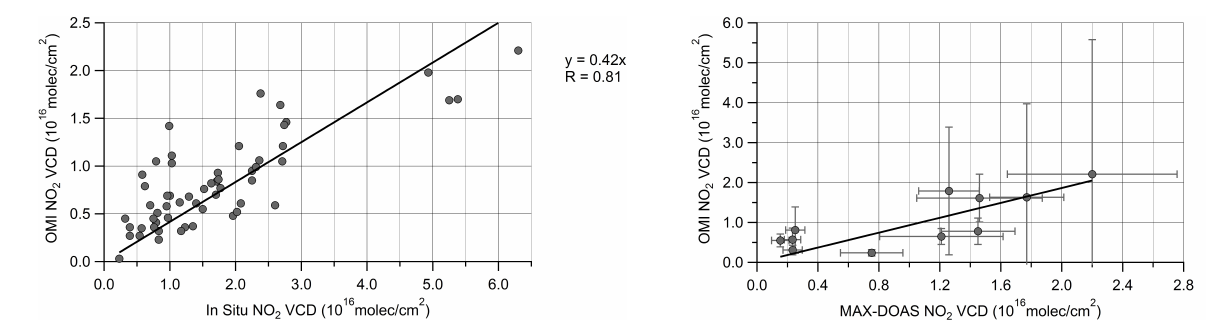
Fig. 5. Linear regression of OMI versus in situ tropospheric NO 2 VCD for data meeting all OMI overpass criteria in Table 4.